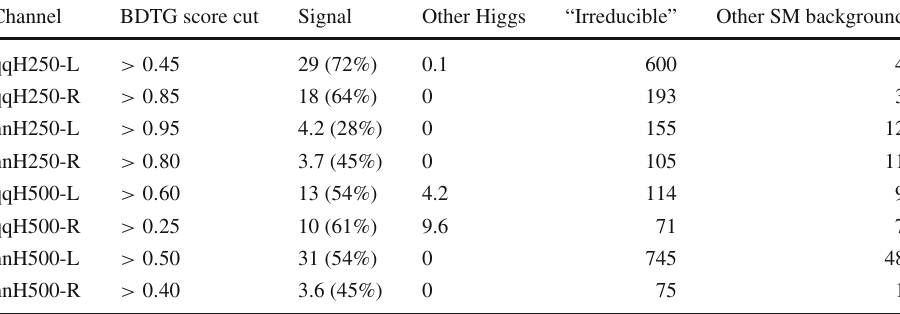
channel after all cuts. The optimal cut on the BDTG